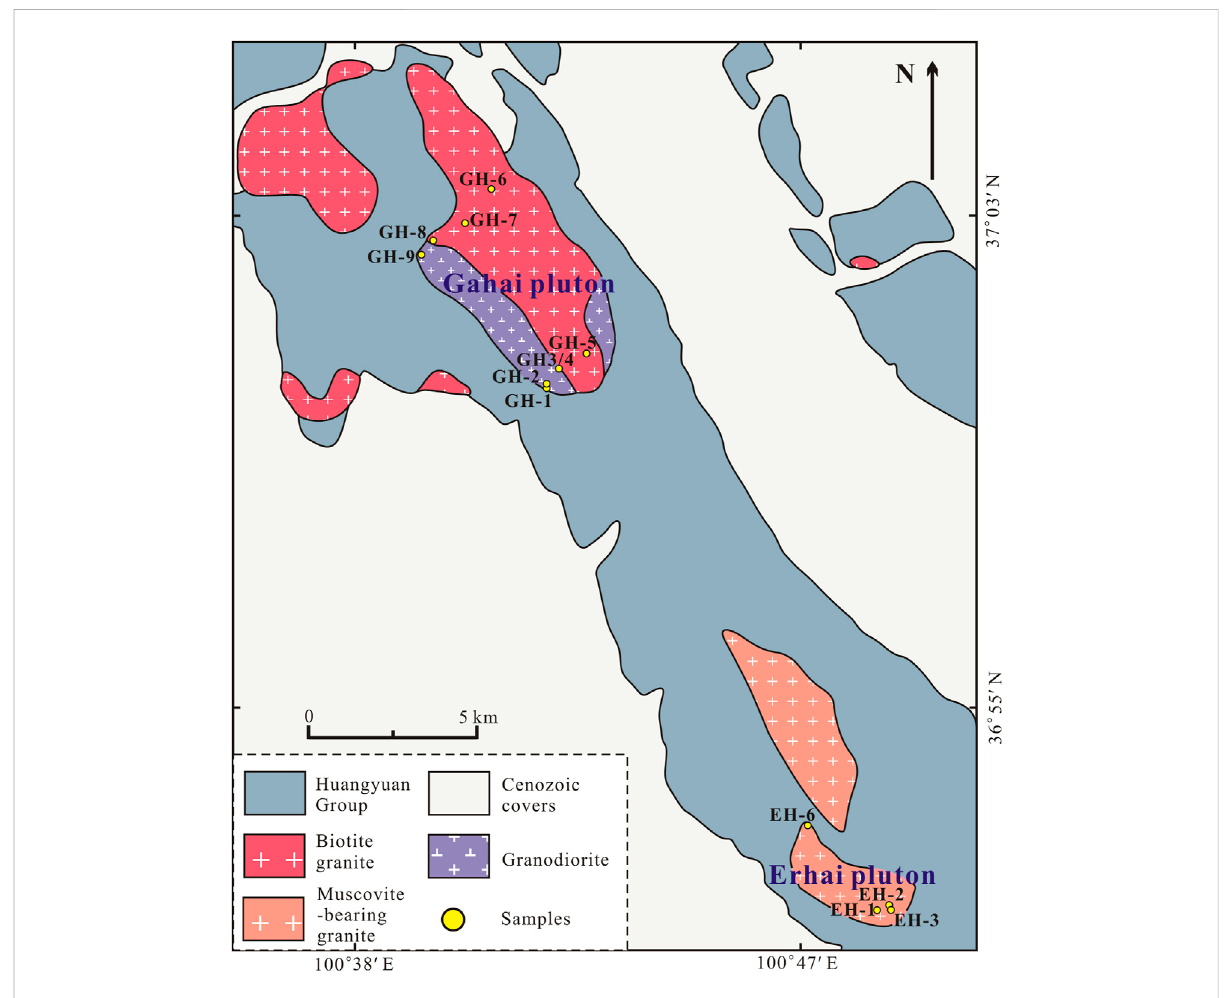
FIGURE 2 Simpli fi ed geological map of the Gahai and Erhai granitoid intrusions in the Haiyan region, northwest China (modi fi ed after 1: 200, 000 geological map of the Haiyan area) showing sample